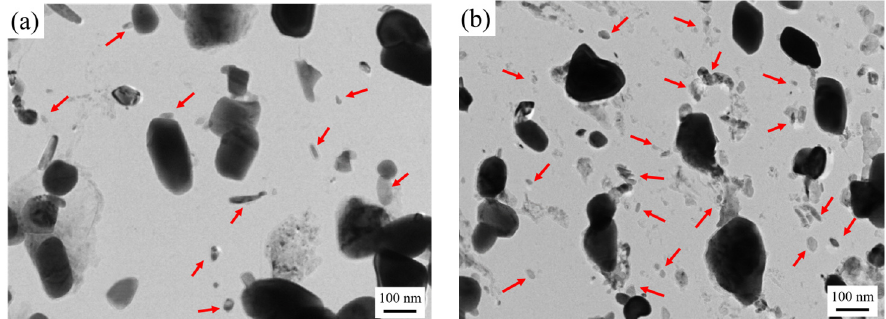
Figure 5. TEM micrographs of carbon extraction replicas of tested steel after tempering for 64 h at 650 °C: ( a ) 0.3 Si; ( b ) 1.0 Si.